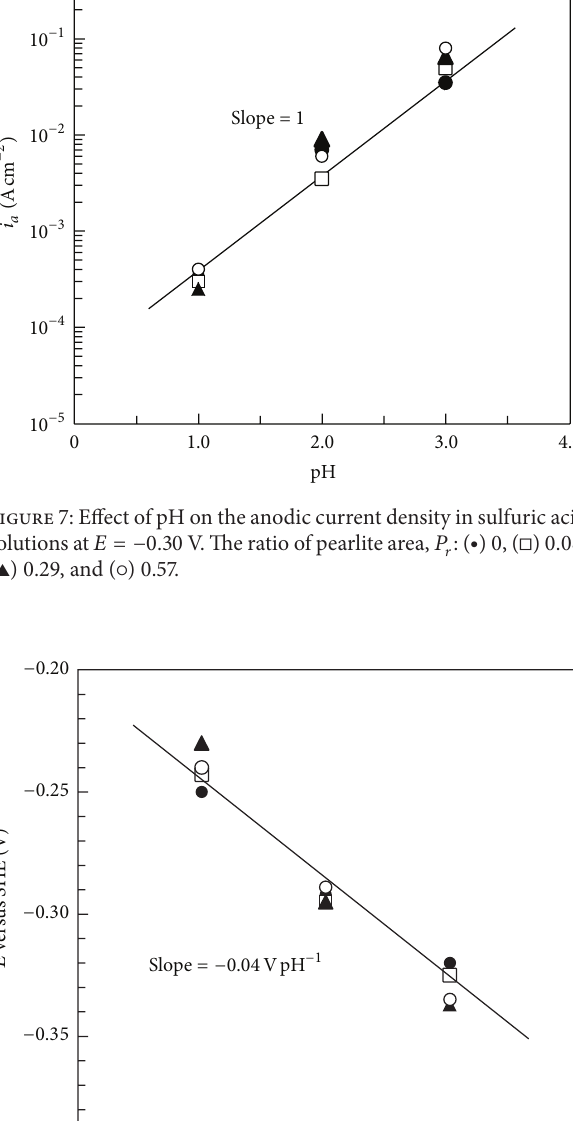
Figure 8: Plots of 𝐸 against pH in sulfuric acid solutions at 𝑖 𝑎 = 0.01 Acm −2 . The ratio of pearlite area, 𝑃 and ( I ) 0.57.